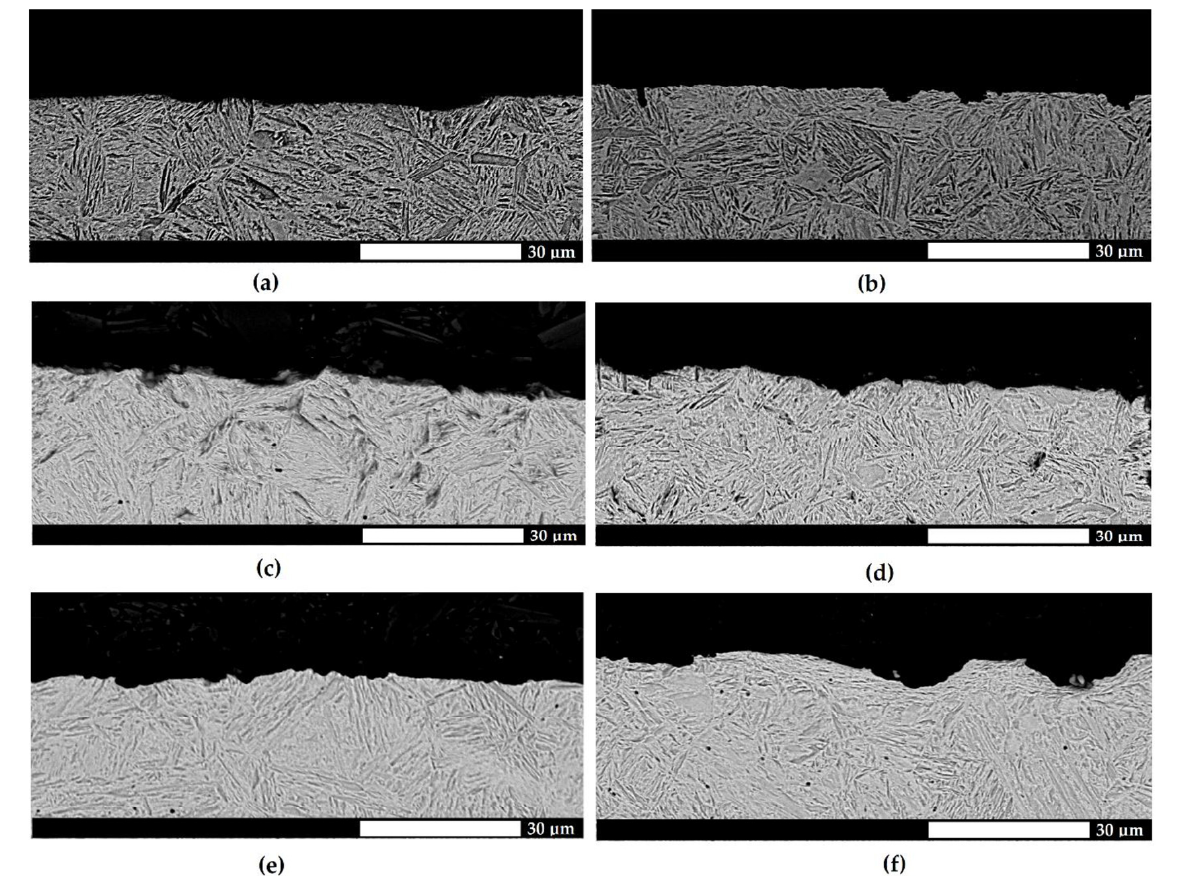
Figure 9. Microstructures of the surfaces subjected to testing for the abrasive wear of Hardox Extreme steel on a cross section transverse to the direction of the abrasive action. ( a , b ) light soil; ( c , d ) medium soil; ( e , f ) heavy soil. Characteristic sharp edges are seen with no distortion of martensite blocks. Electron microscopy, etched with Mi1Fe (Nital).